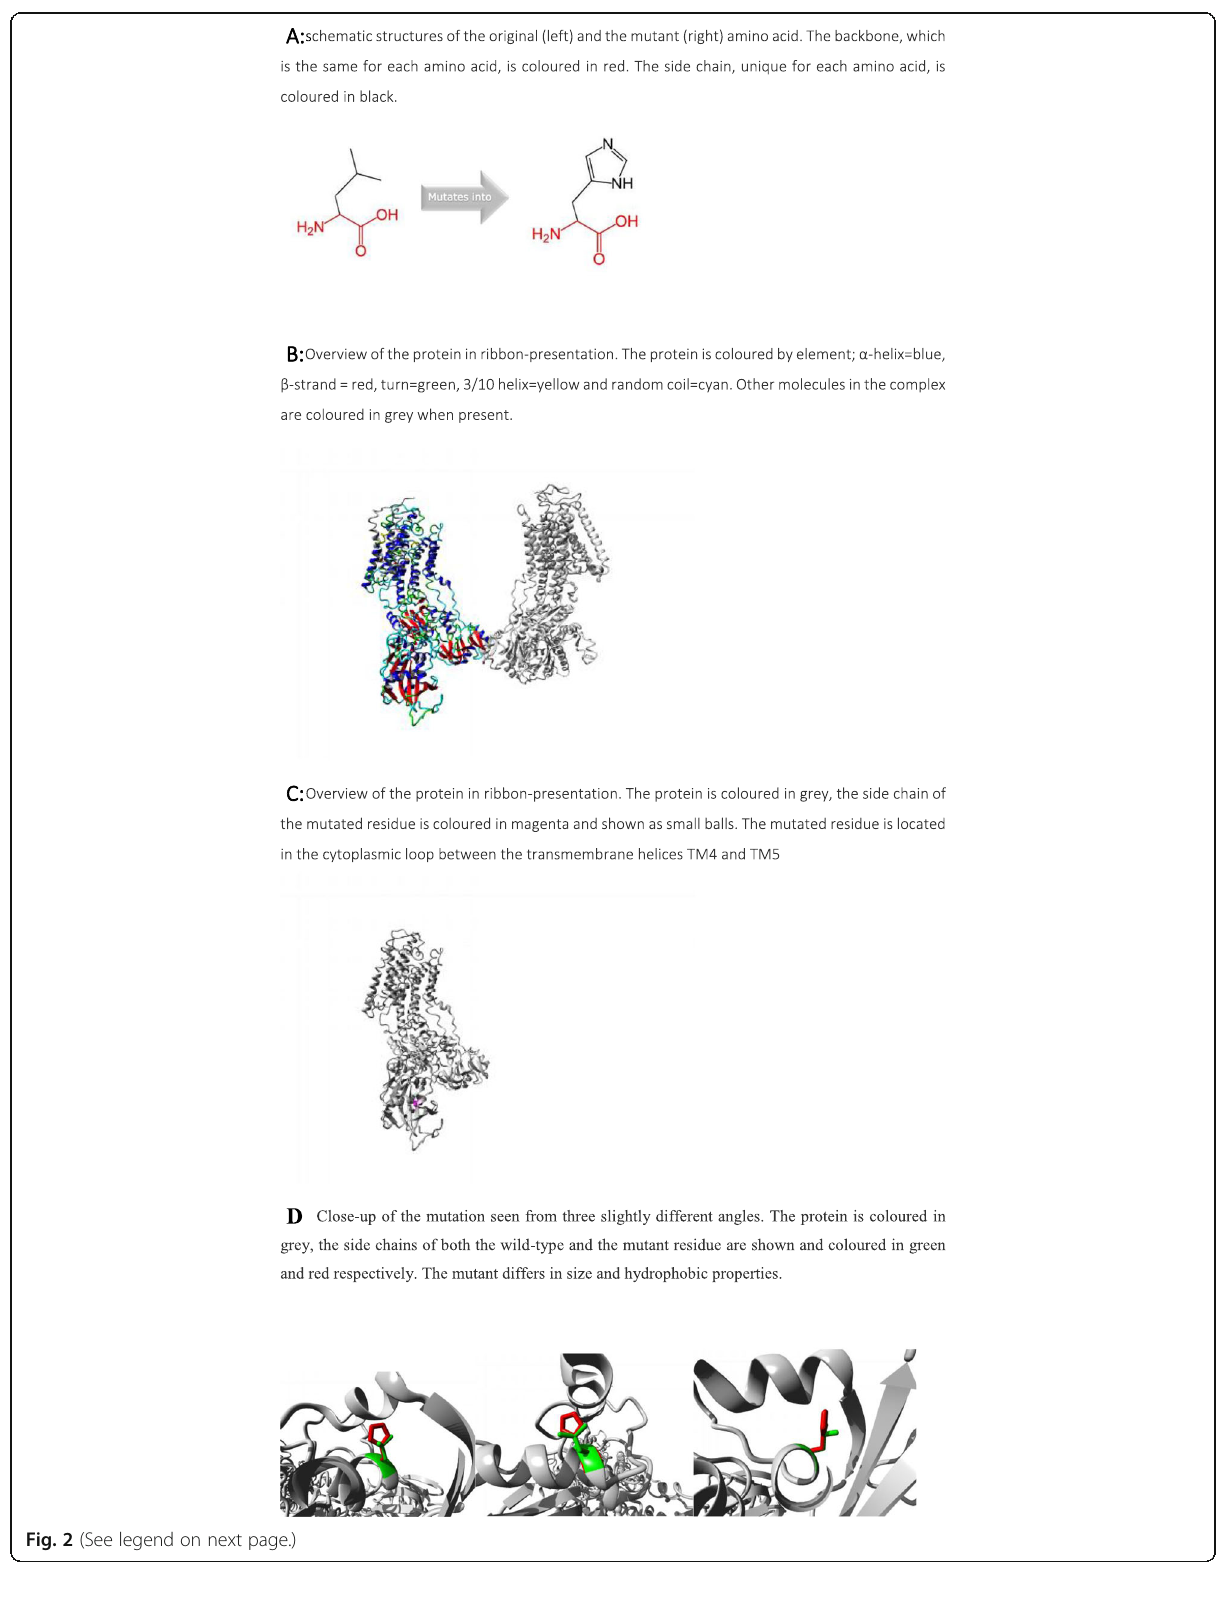
Fig. 2 (See legend on next